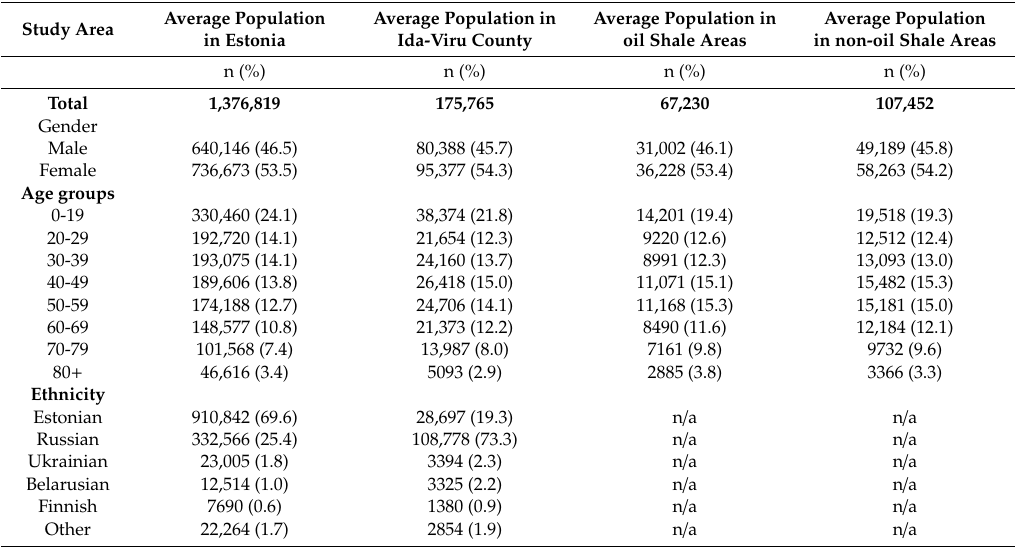
Table 1. Demographic characteristics of the average population in Estonia and in Ida-Viru County in 1992-2015. Average Population Study Area in